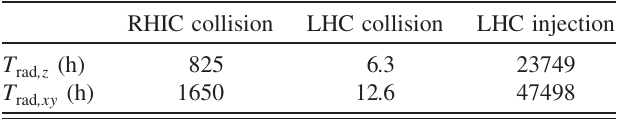
TABLE V. Calculated radiation damping times for the emit- tances in RHIC and LHC. The damping is equal in the transverse planes.